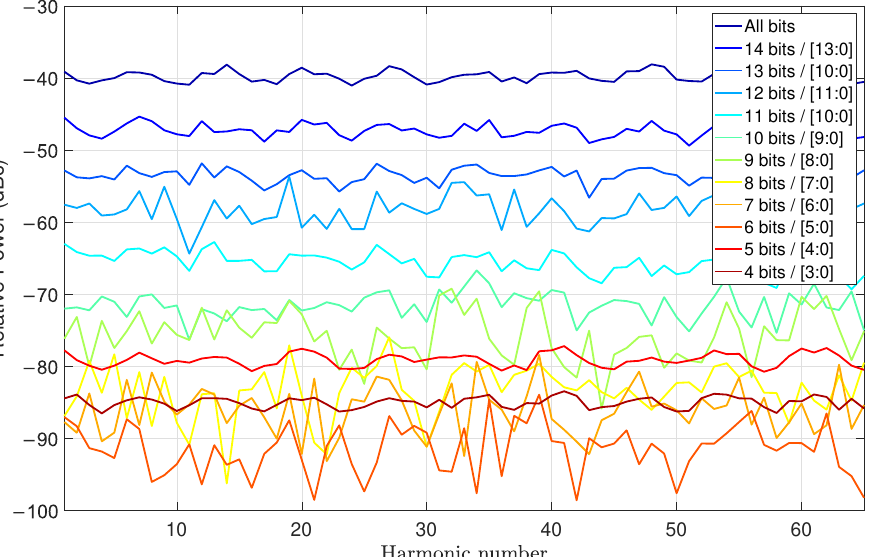
Figure 6. The relative power levels of sidebands in the 15 bit maximum-length LFSR modulated test signals generated using the AD9910